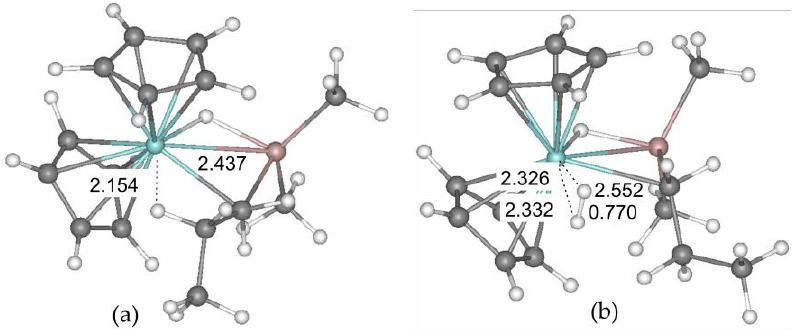
Figure 4. Calculated geometries of I-2H_bo ( a ) and dihydrogen complex I-2H_H2 ( b ). The distances